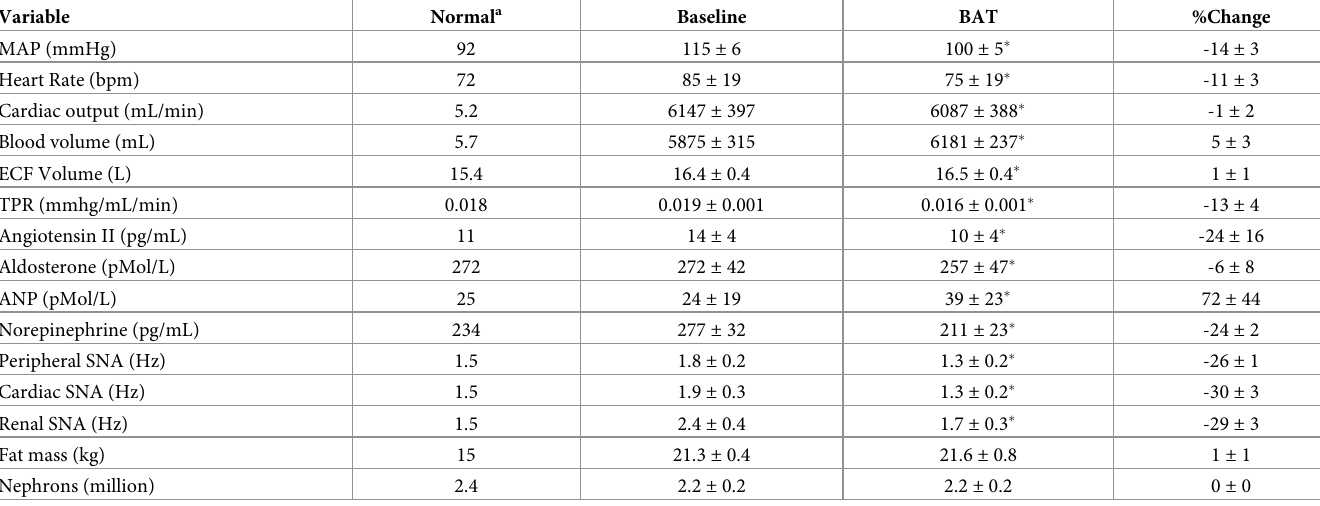
Table 1. Cardiovascular, hormonal, and neural variables at normal model conditions and in the calibrated hypertensive virtual population (n = 60) before and after 1 month of baroreflex activation therapy. Variable Normal